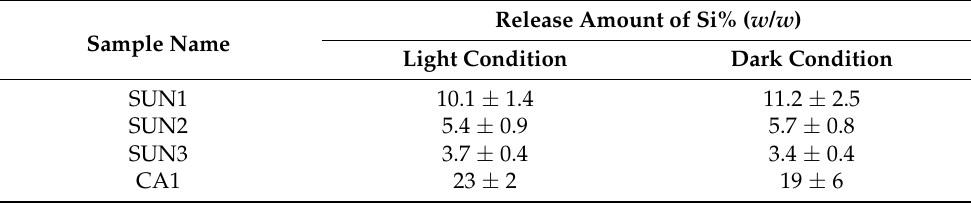
Table 2. The concentration of Si released from SUN1–3, CA1, and